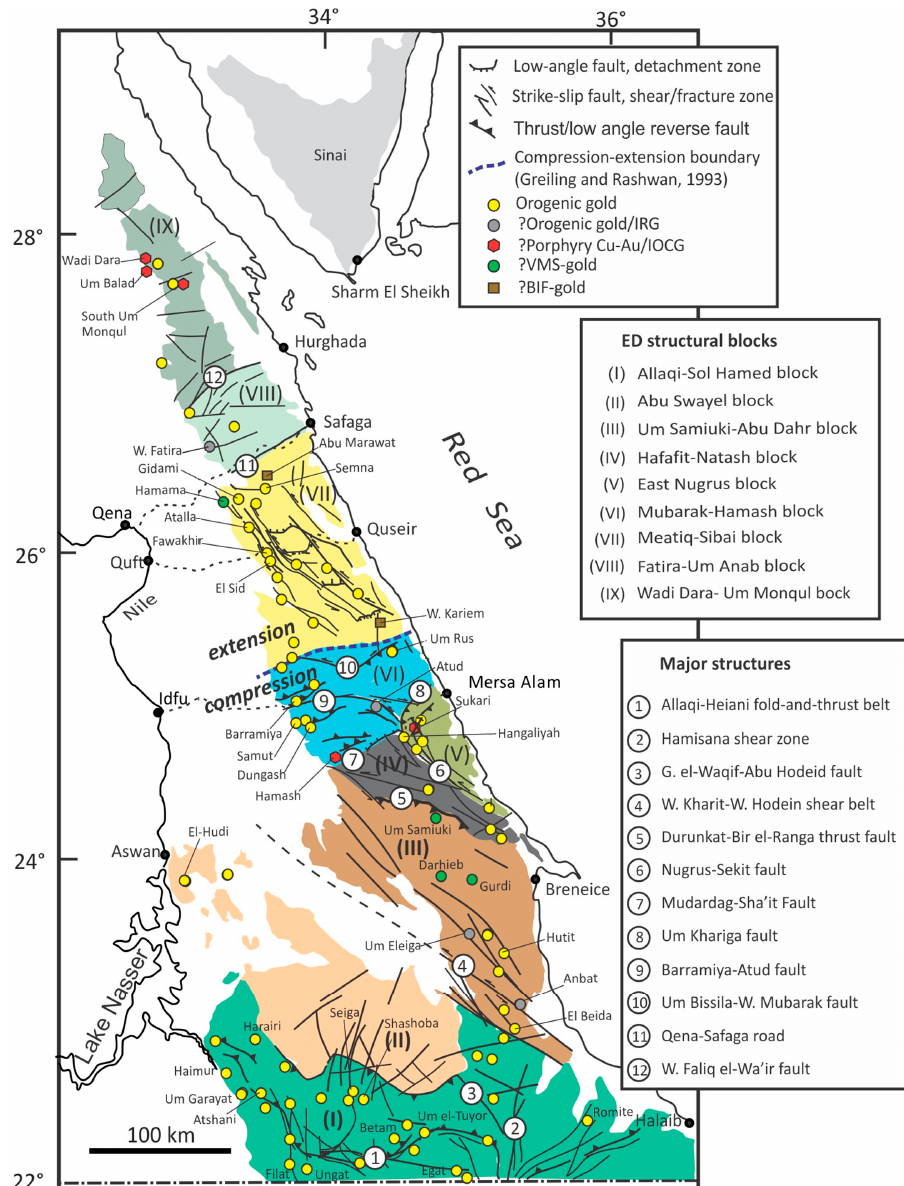
Figure 1. Gold occurrences in the main structural blocks in the Eastern Desert of Egypt [9].